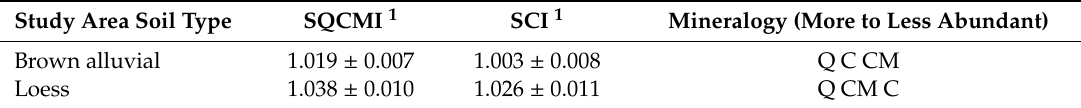
Table 2. Spectral indices and mineralogy of soil surface.